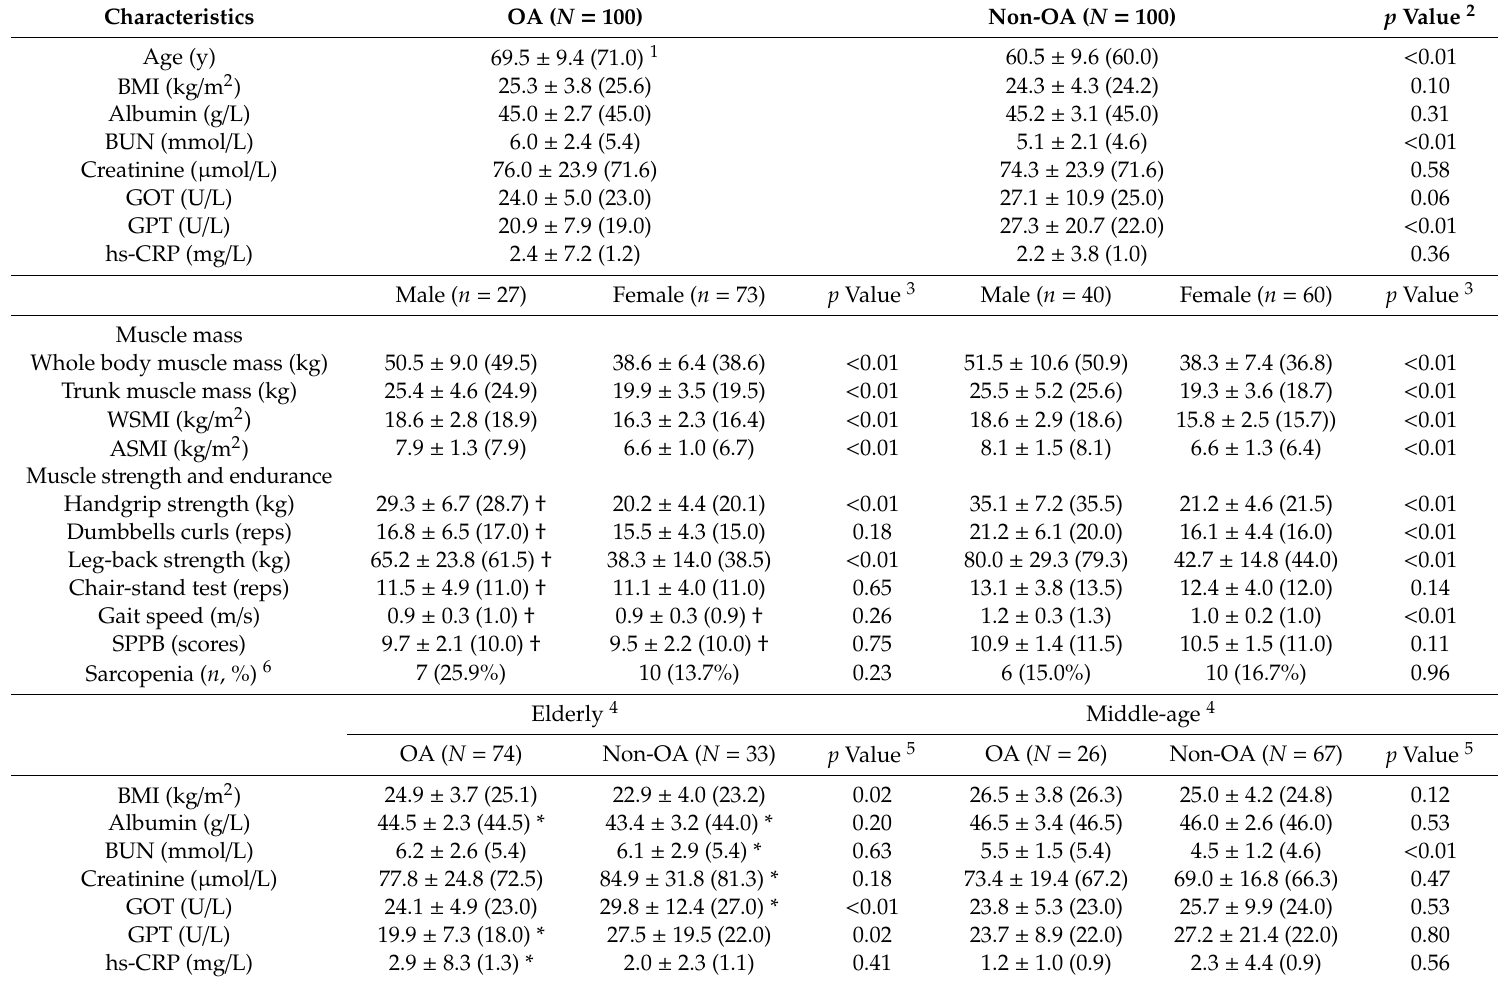
Table 2. Characteristics of the